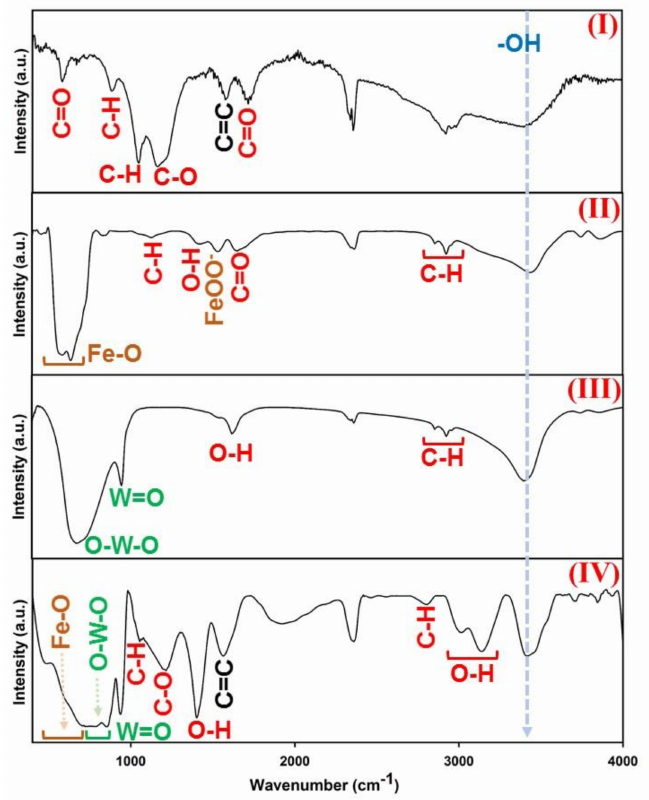
Figure 3. FTIR spectrum of (I) GO, (II) Fe 3 O 4 , (III) H 2 WO 4 , and (IV) GO-ITN hybrid